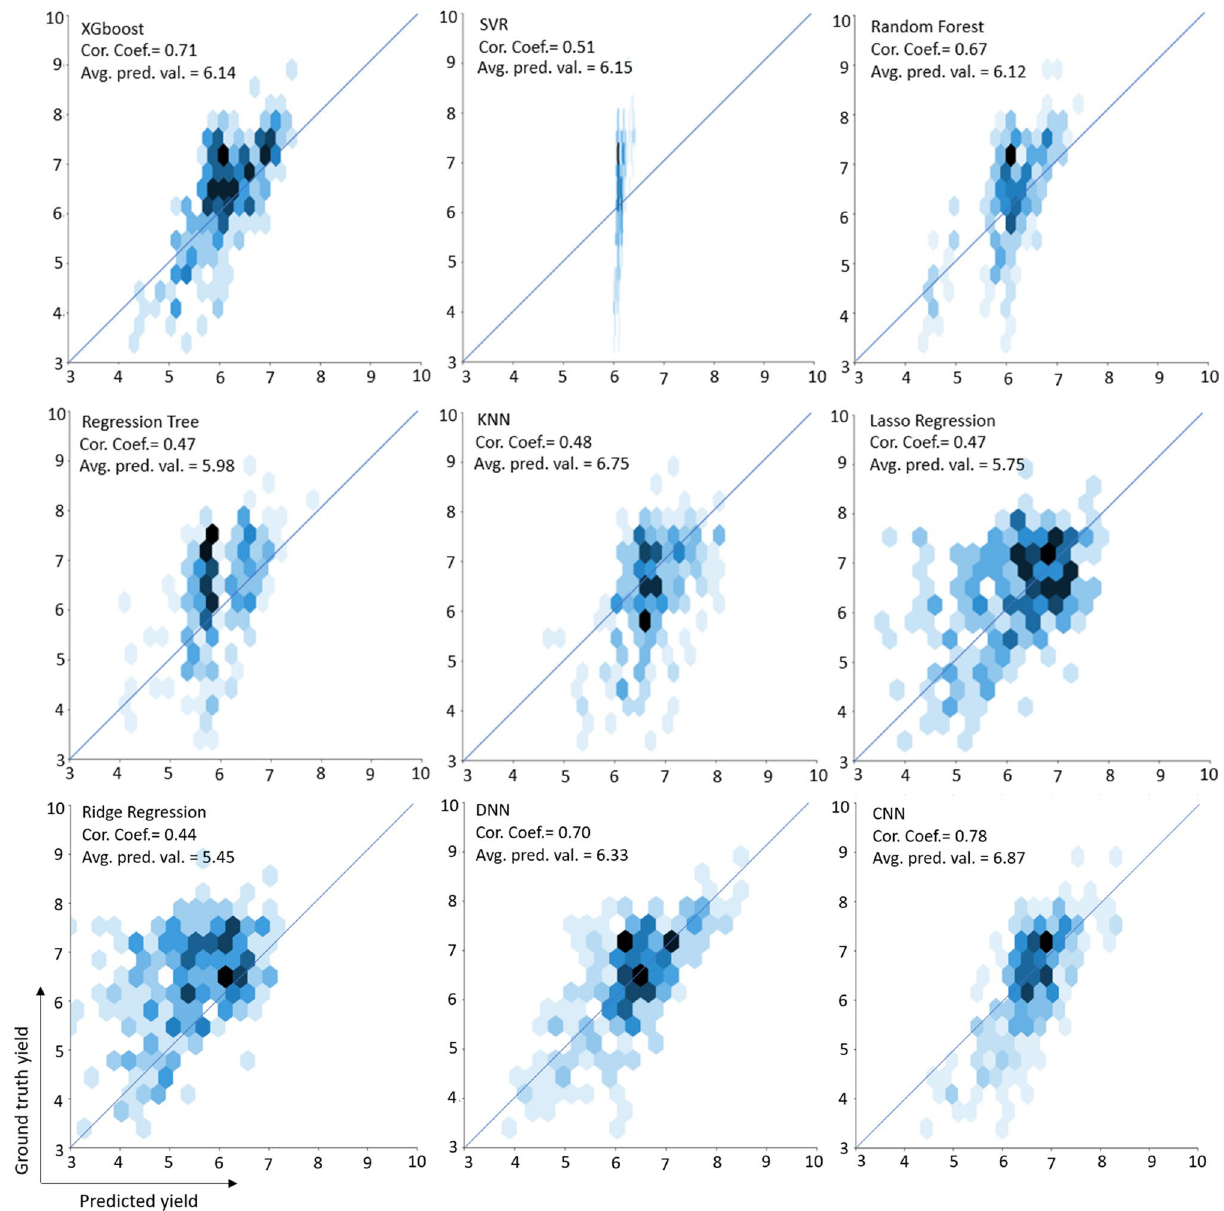
Figure 4. Hexagonal plots of the predicted winter wheat yield vs. ground truth yield values for the nine machine learning models in the test year of